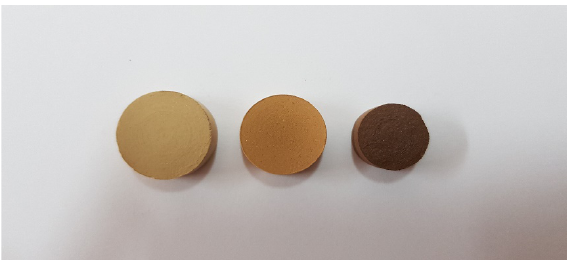
Figure 8: Shrinkage and the obvious change in color of cylinders of trepel sintered at 800, 1000 and 1200°C for a period of 60 min.